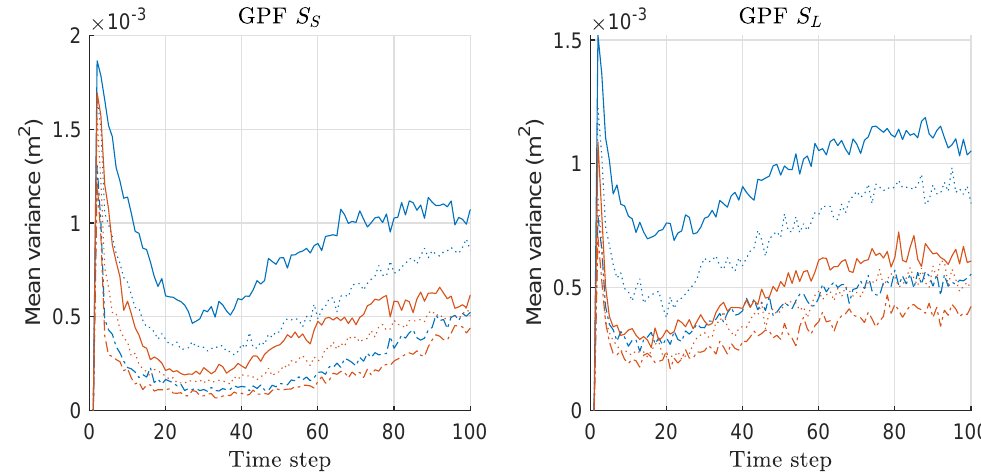
Figure 15. Mean-variance of the weights of particles over 300 runs with 1000 particles for GPF and MGPF. These results are associated with the results of MDE and mean-risk of Figures 13 and 14. Legend: line style (dash-dot: M = 2; dotted: M = 5; solid: M = 10); (line color: blue: GPF; red: